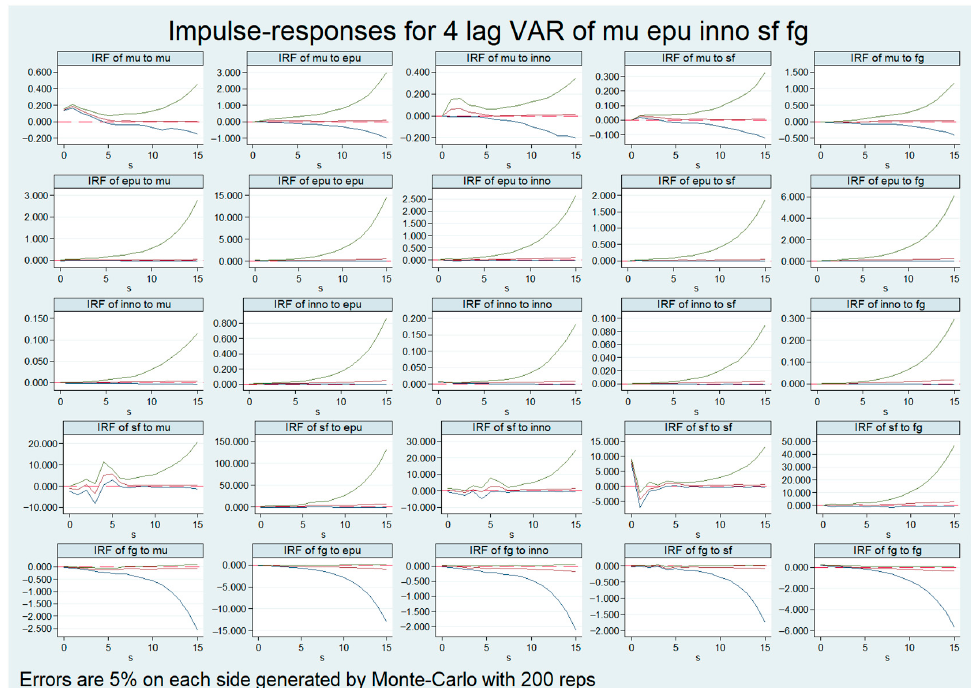
Figure 4. Orthogonalized impulse response function (OIRF).